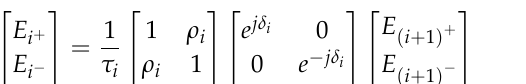
(i.e., θ from the surface normal), the longitudinal phase constant is given by δ z = kl cos θ while the characteristics impedance for horizontal (H) and vertical (V) polarizations are given by η T = η / cos